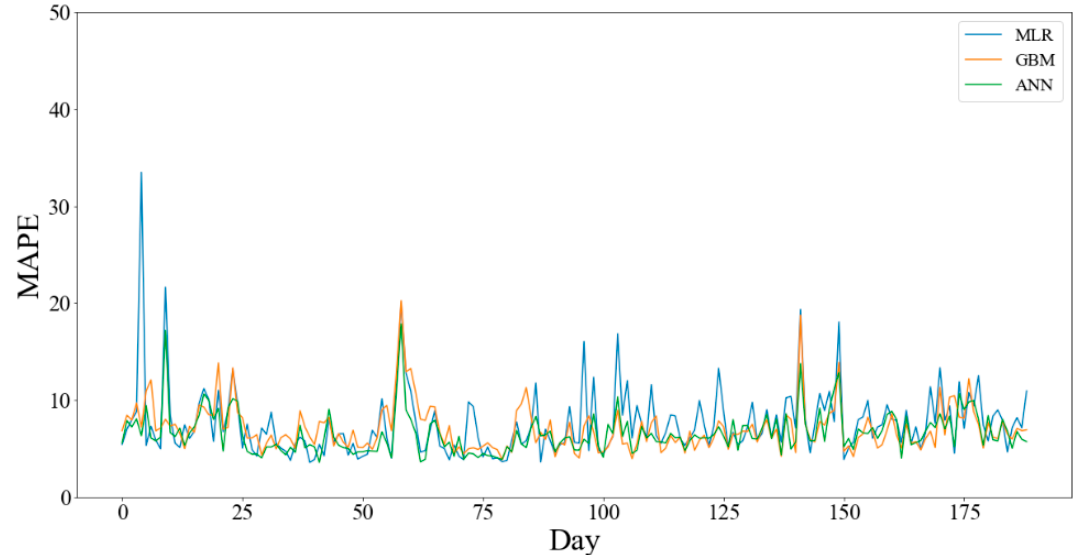
Figure 6. MAPE over time for the ANN, the GBM, and ADB.